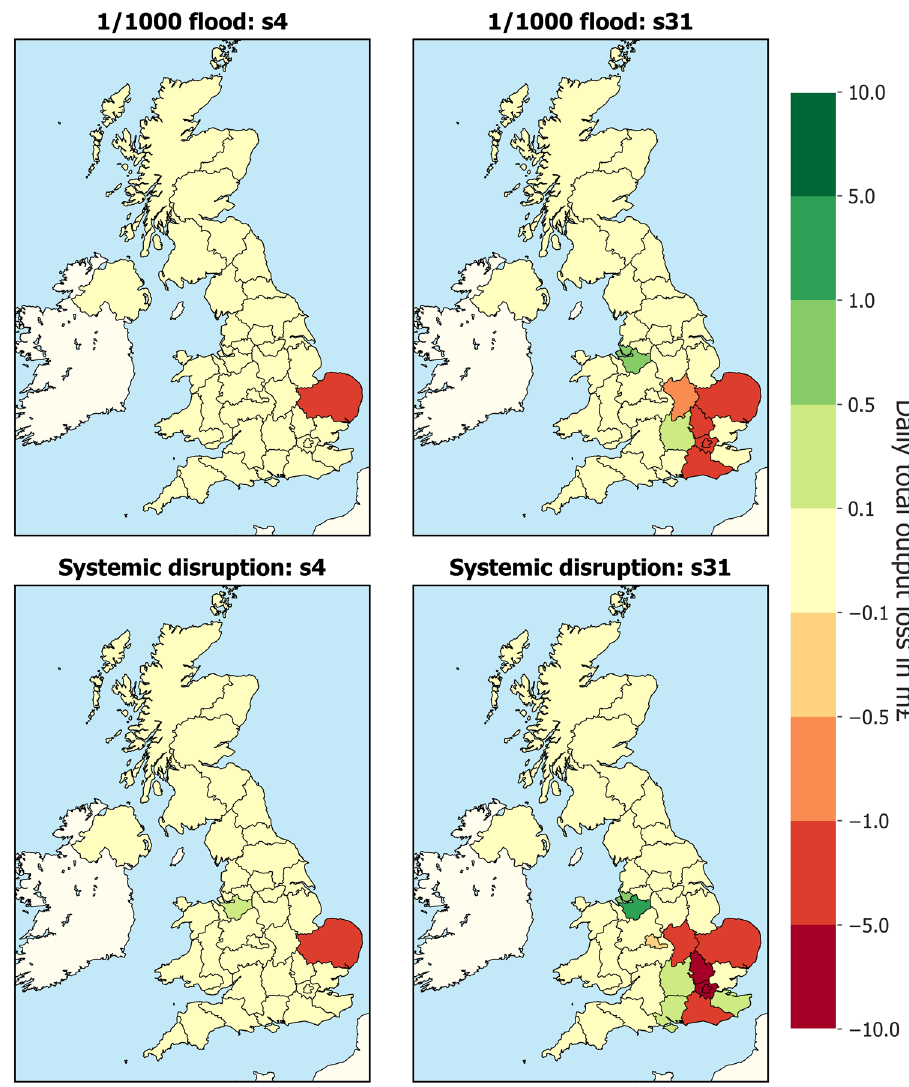
Fig. 8 Daily impacts for four scenarios in each NUTS2 (Nomenclature of Territorial Units for Statistics, level 2) region of the United Kingdom. The upper left and upper right panels show the impacts due to a 1/1000 flood for scenarios 4 and 31, respectively. The lower left and lower right panels show the total impact due to infrastructure failure and a 1/1000 flood for scenarios 4 and 31,